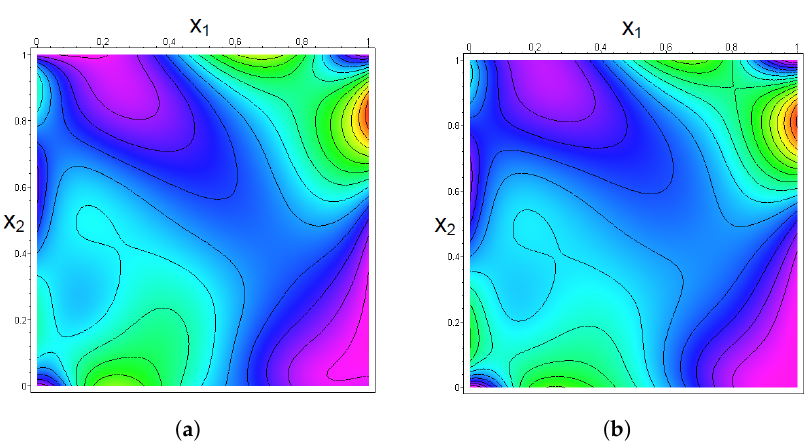
Figure 8. Contour plots for the Bernstein copula densities in Example 3. ( a ) Bernstein copula density